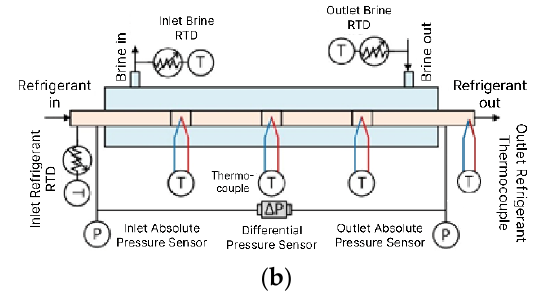
Figure 1. Schematic diagram of the experimental system.